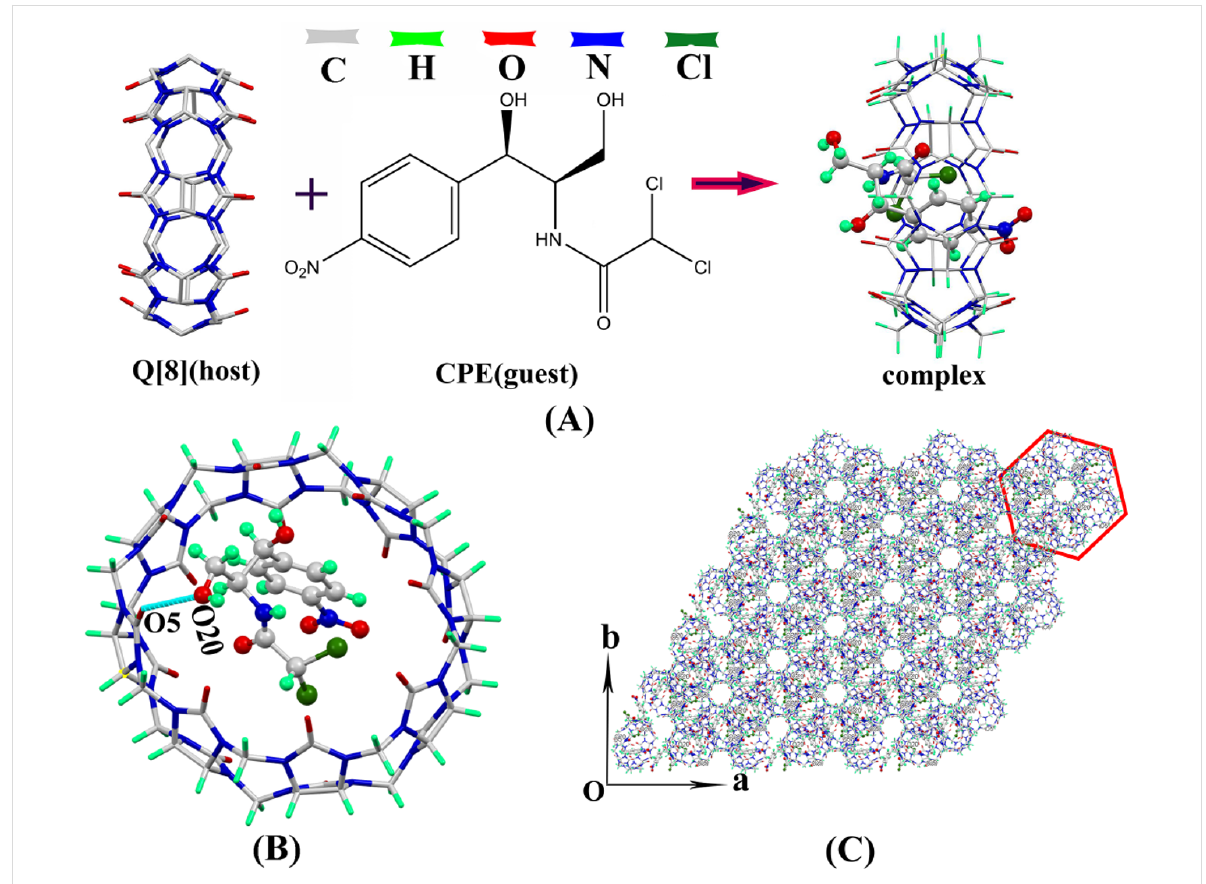
Figure 2: (A) CPE and Q[8] structural model diagram, (B) interaction between CPE and Q[8], (C) CPE@Q[8] stacked graph along the c-axis.